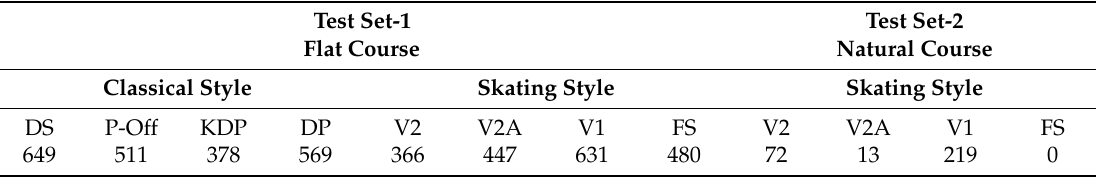
Table 6. Number of cycles of the classical (DS, P-Off, KDP, DP) and skating (V2, V2A, V1, FS) techniques performed by skier 4 in the test set-1 and test